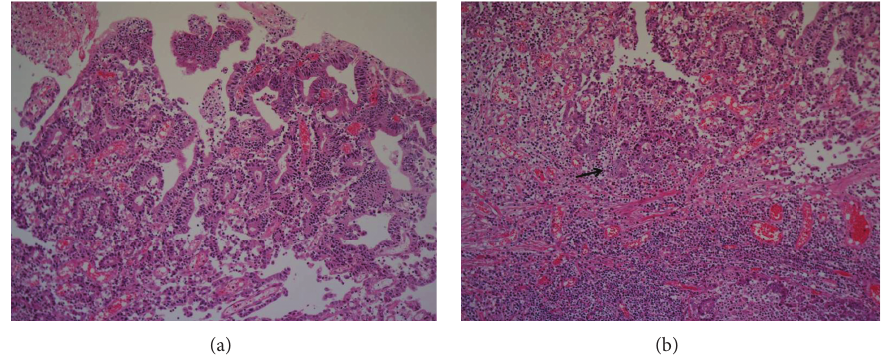
Figure 3: (a) Surface of the 0-I lesion showed tub2 (HE × 25). (b) Tumor was poorly-differentiated at the front of intramucosal invasion (arrow: HE × 25).